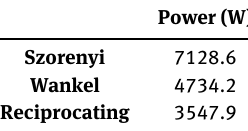
Table 4: Power output comparison of one chamber of the Szorenyi, Wankel and a Piston